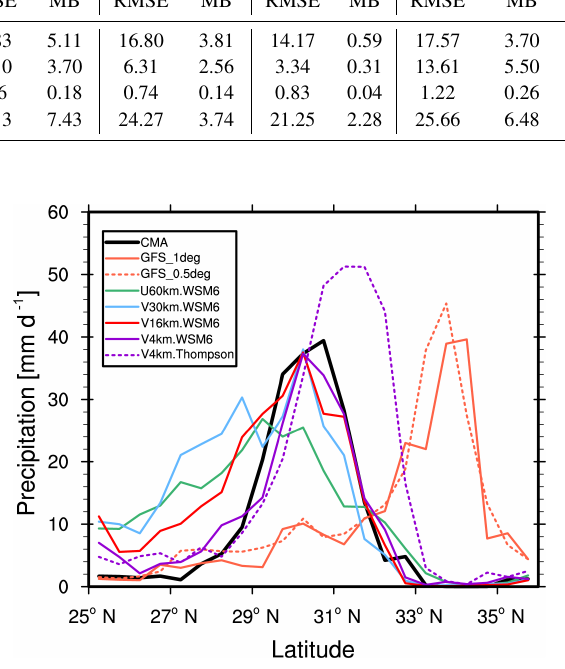
Figure 7. Zonal distributions of precipitation averaged during the event averaged over East China (denoted as the black box in Fig. 6) from the CMA station observations and the simulations with reso- lutions of 60, 30, 16, and 4km. For comparison, the GFS forecasts at 1 and 0.5 ◦ resolutions are also included. The modeling results are sampled at the CMA